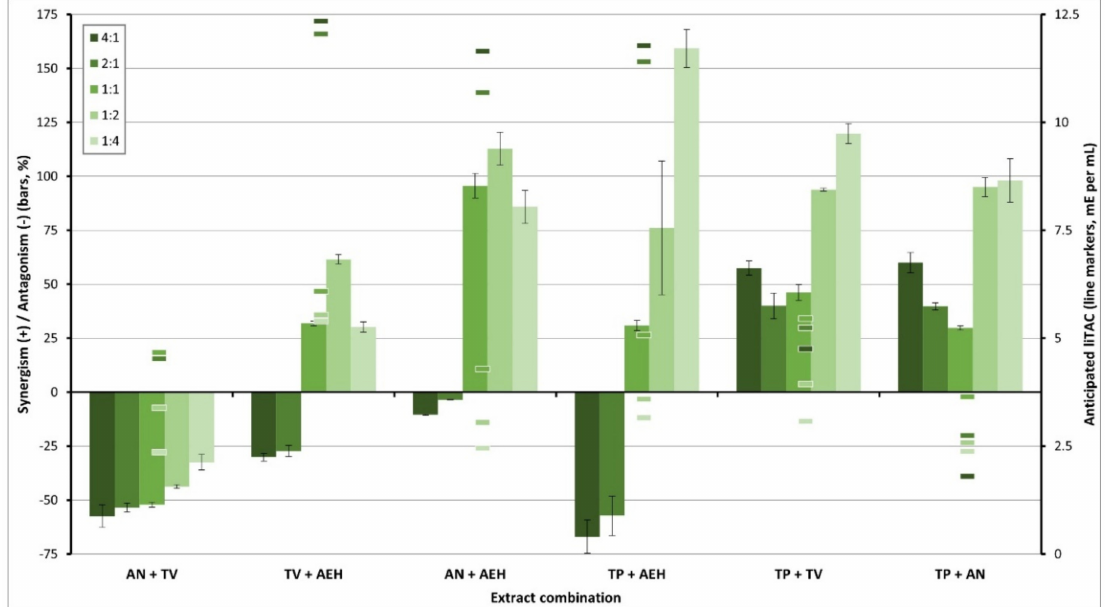
Figure 4. Base total antioxidant capacity (TAC) and determined synergistic effects of different plant-based extracts in combination, analysed via liTAC Assay. Primary ordinate (bars): synergistic (+) or antagonistic ( − ) effect of extract combinations ( n = 3; standard deviation indicated via error bars). Secondary ordinate (horizontal markers): absolute base TAC, based on TAC determination of pure extracts ( n = 6) and subsequent mathematical accumulation. AN: Abies nordmanniana extract; TV: Thymus vulgaris extract; AEH: Aesculus hippocastanum extract; TP: tomato paste extract; mE: milli extinction